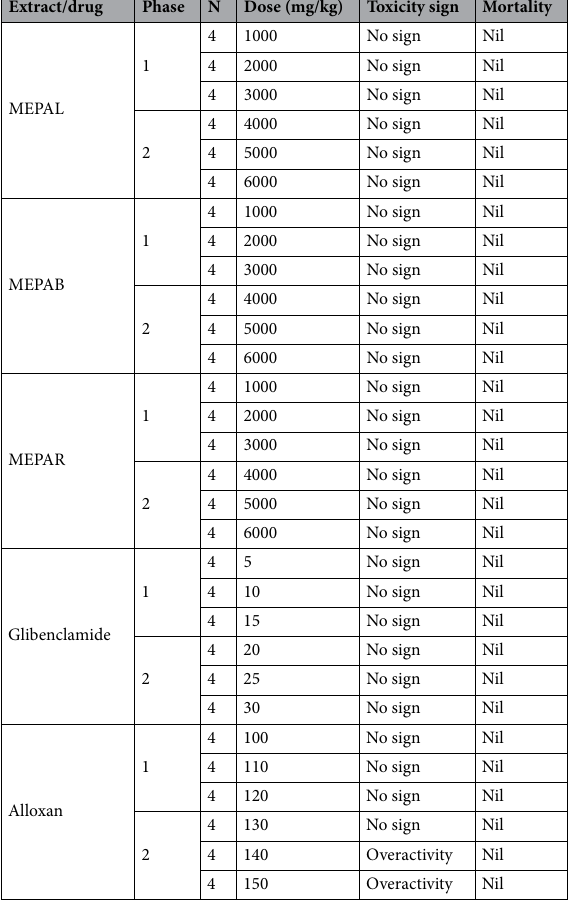
Table 6. Acute toxicity (LD 50 ) test of P. americana leaf, seed and root extract, as well as glibenclamide and alloxan. N number of rats, MEPAL methanol extract of P. americana leaf, MEPAB methanol extract of P. americana bark, MEPAR methanol extract of P. americana root.